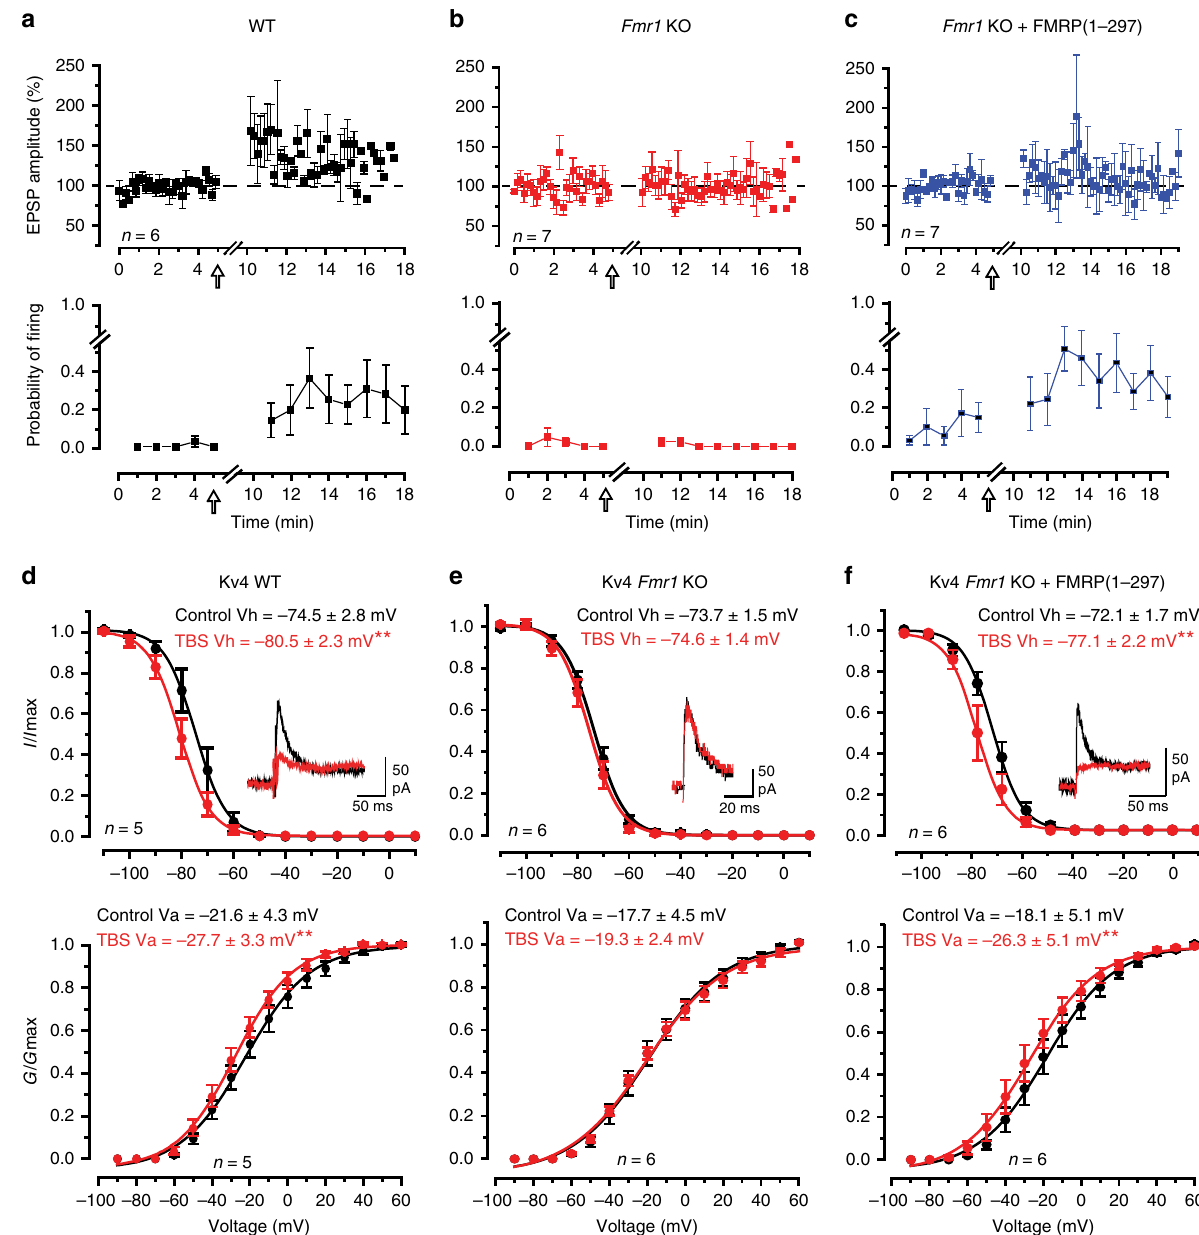
Fig. 1 Mossy fi ber evoked LTP and modulation of Kv4 properties are lost in Fmr1 KO mice. a – c Plots of the mean amplitude of the mossy fi ber-evoked EPSP and probability of fi ring per stimulus in whole-cell recordings of lobule 9 granule cells. EPSP amplitudes were only calculated for stimuli that were subthreshold to spike discharge and probability of spike fi ring was averaged for every 1-min interval (6 stimuli). a , b Theta burst stimulation (TBS, indicated by arrow) of mossy fi ber input evokes LTP of the EPSP and an increase in probability of fi ring in granule cells of WT mice ( a ) (% change of EPSP: 138.8 ± 11.0%; fi ring probability: resting condition 0.5 ± 0.5%, after TBS 25.0 ± 11.4%, n = 6 cells from 6 mice) but not Fmr1 KO mice ( b ) (% change of EPSP: 100.6 ± 5.2%; fi ring probability: resting condition 1.4 ± 1.5%, after TBS 0.5 ± 0.6%, n = 7 cells from 7 mice). c Infusing 3 nM FMRP(1 – 297) into granule cells of Fmr1 KO mice rescues LTP of spike fi ring probability but not EPSP amplitude (% change of EPSP: 103.6 ± 10.3%; fi ring probability: resting condition 9.5 ± 7.5%, after TBS 35.8 ± 10.4%, n = 7 cells from 6 mice). d – f Plots of the voltage for inactivation and activation of Kv4 current in granule cells in